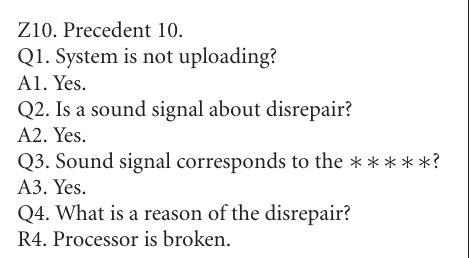
Figure 16: Immersing the ES to SIS QA .